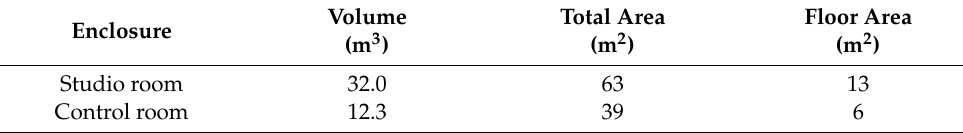
Table 7. Dimensions of the enclosures.